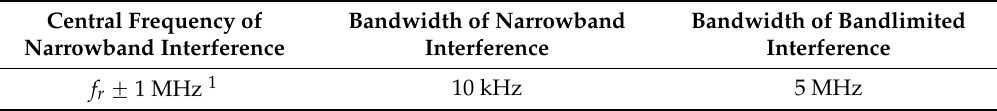
Figure 4. Anti-interference rate of ACE-BOC under three kinds of interference: narrowband interference, bandlimited interference and matched spectrum interference. Receiving strategies are IMR and BLR for component s LQ . Larger value means more vulnerability to such interference. Table 2. Interference parameters in the evaluation scenario. This configuration is effective in Sections 6.2.3 and 7.2.3.